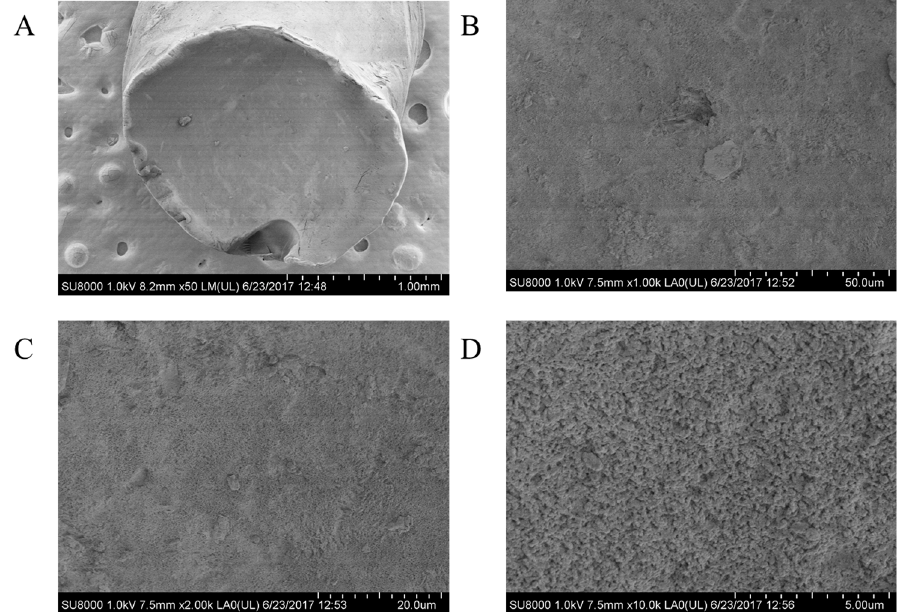
Figure 5. SEM images of the CsB aerogels. ( A ) 50×; ( B ) 1000×; ( C ) 2000×; and, ( D ) 10,000× magnification.